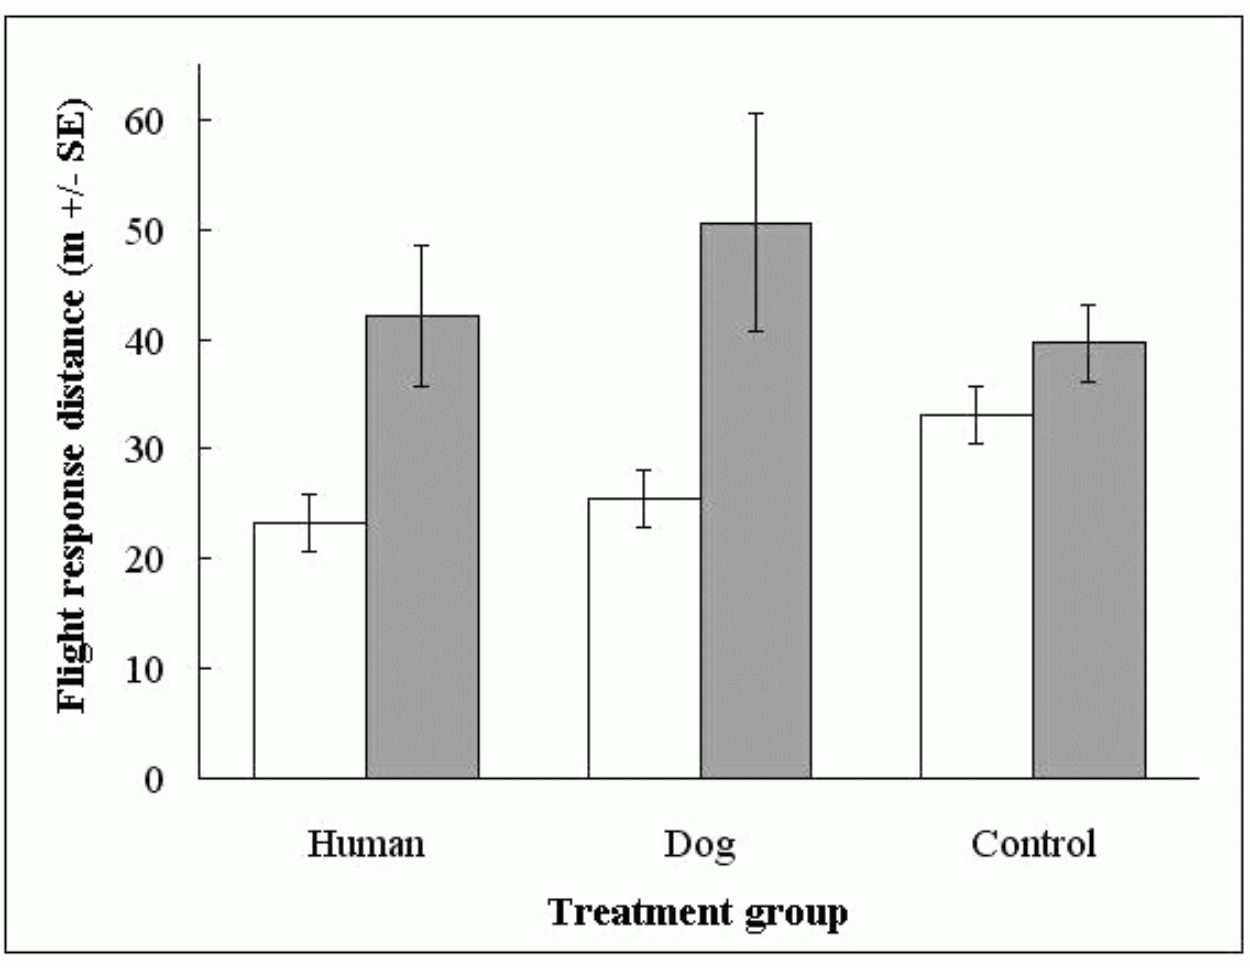
Fig. 2. Elk flight response distance (m ± SE) before (white column) and after (black column) aversive conditioning treatments were applied to the three treatment groups in Banff National